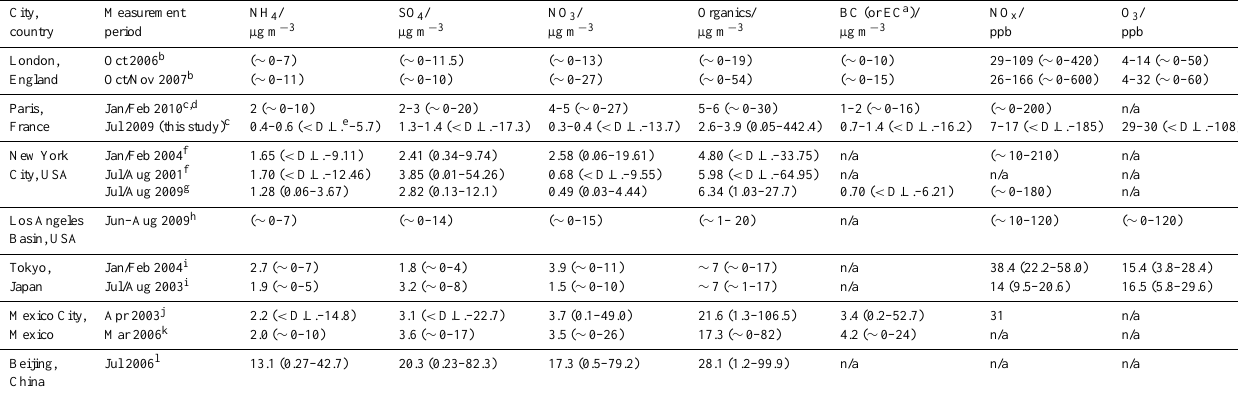
Table 6. Selected results from measurements in megacities worldwide. Values represent the averages over the respective measurement period; values in parentheses represent the lowest and highest value